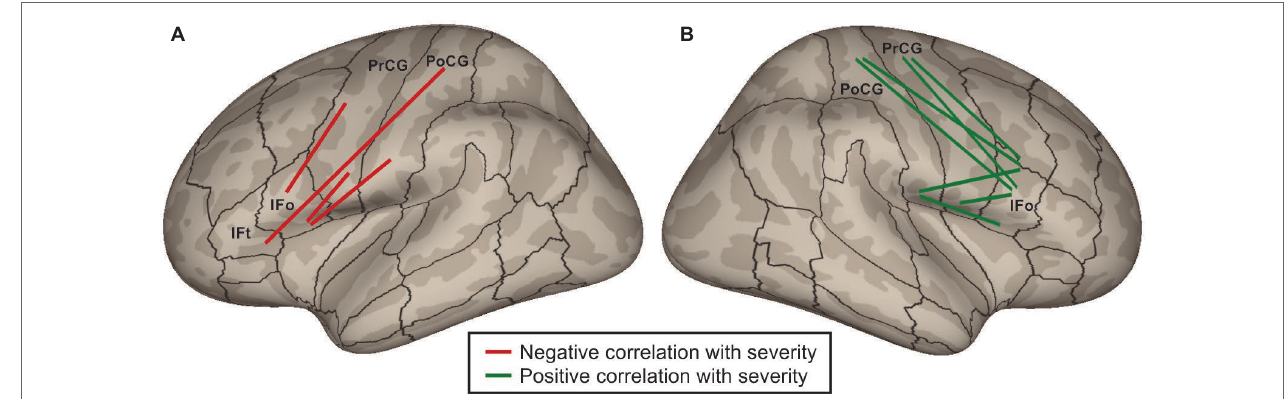
FIGURE 4 | Schematic of intra-hemispheric white matter tracts between inferior frontal cortical regions and Rolandic cortical regions whose strengths are significantly correlated with stuttering severity (Cai et al., 2014) plotted on (A) left and (B) right lateral inflated cortical surfaces. Red tracts indicate a negative correlation with severity (i.e., weaker tracts are associated with higher severity); green tracts indicate a positive correlation. (Abbreviations: IFo = inferior frontal gyrus pars opercularis; IFt = inferior frontal gyrus pars triangularis; PoCG = postcentral gyrus; PrCG = precentral